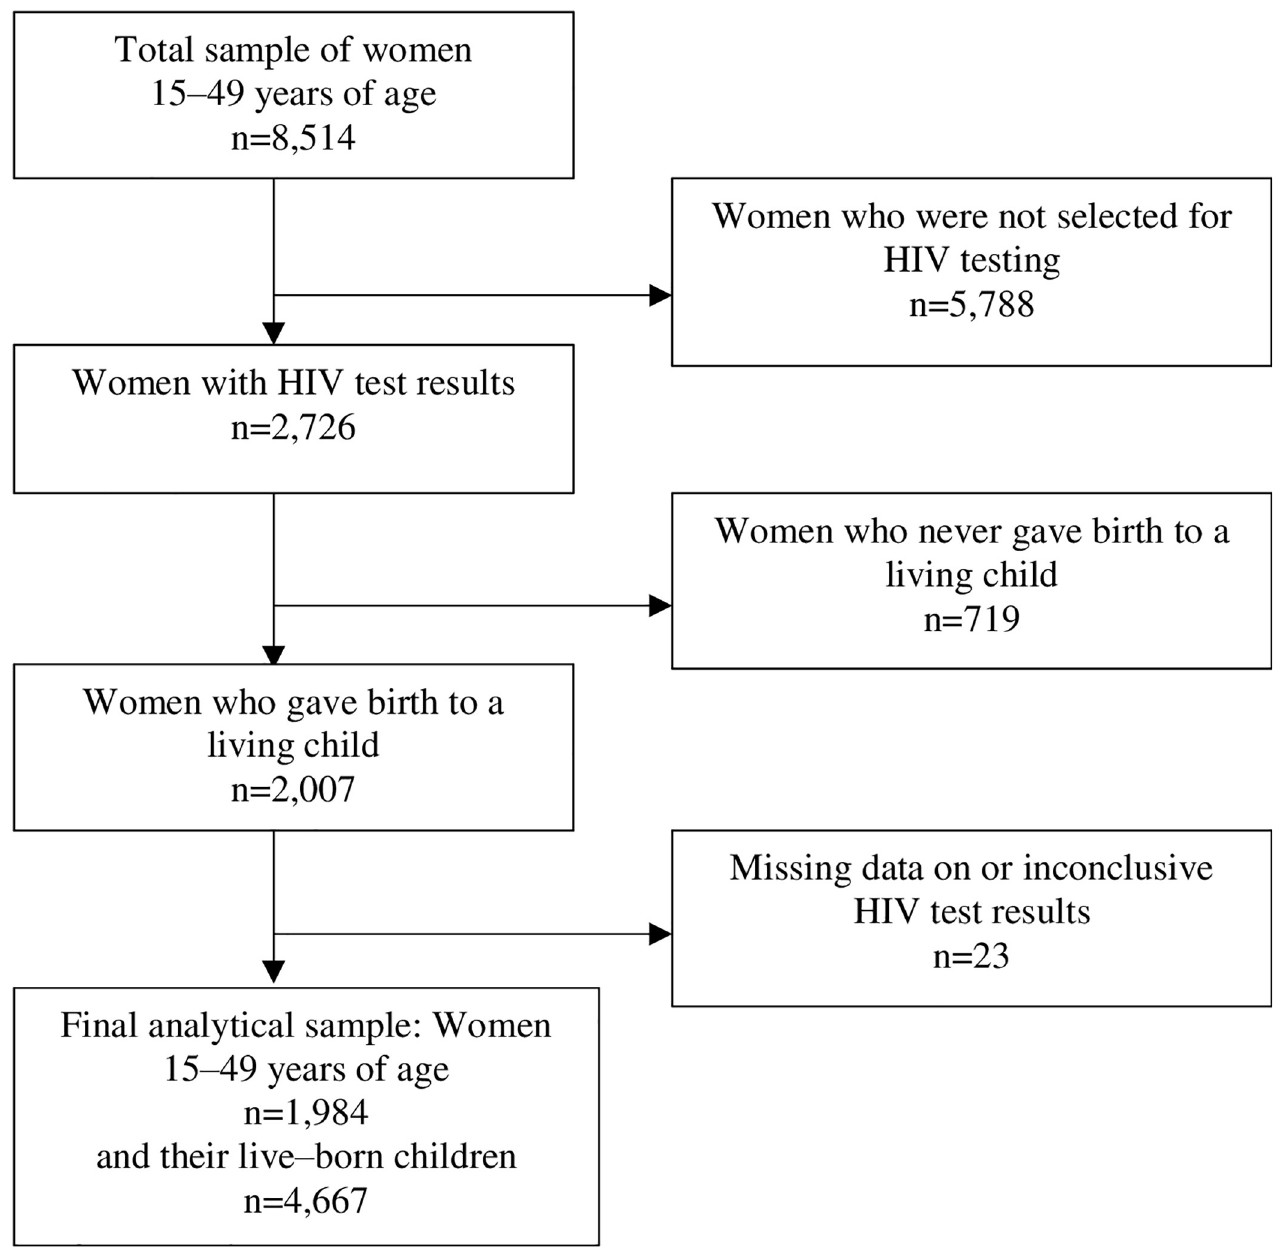
Fig 1. Analytic sample selection, South Africa Demographic Health Survey (SADHS) 2016. This flow chart depicts the steps in narrowing the sample from the full number of women 15–49 years of age available in the data source to the number included in our analyses. South Africa Demographic Health Survey (SADHS) 2016